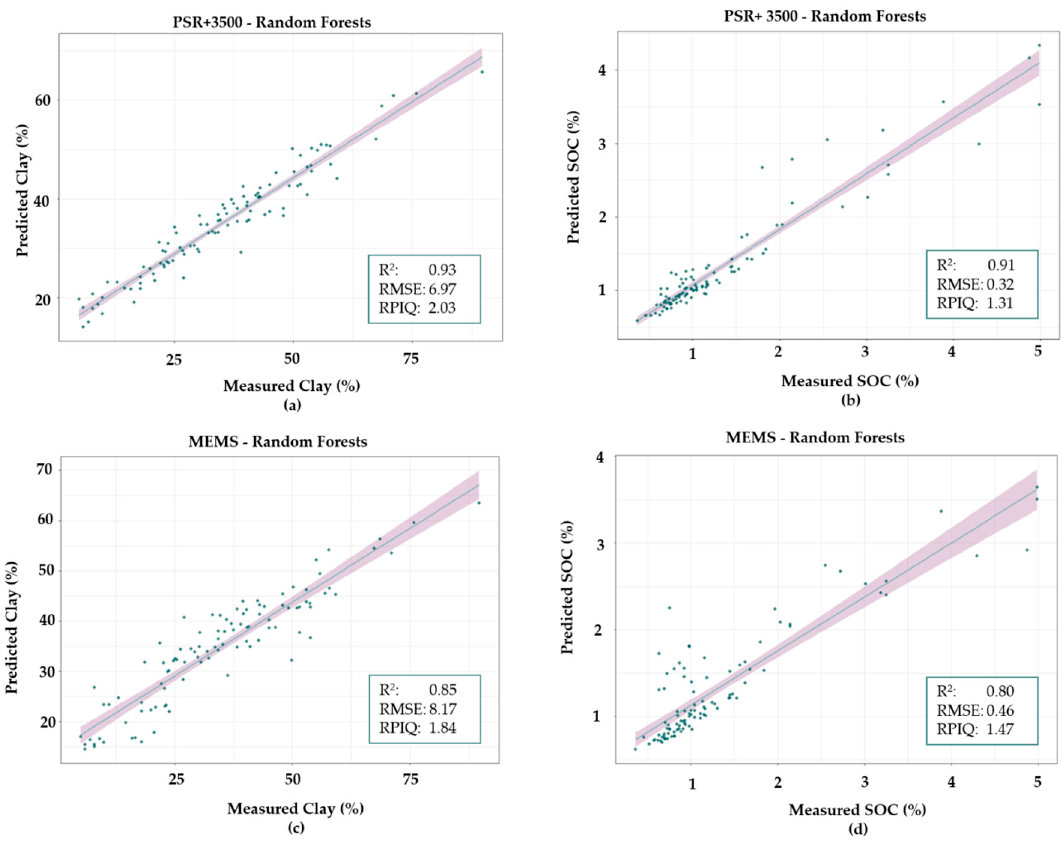
Figure 7. Predicted versus measured soil attributes scatterplots for RF fitted models using different sensors. PSR+ 3500 ( a , b ), and MEMS ( c , d ).